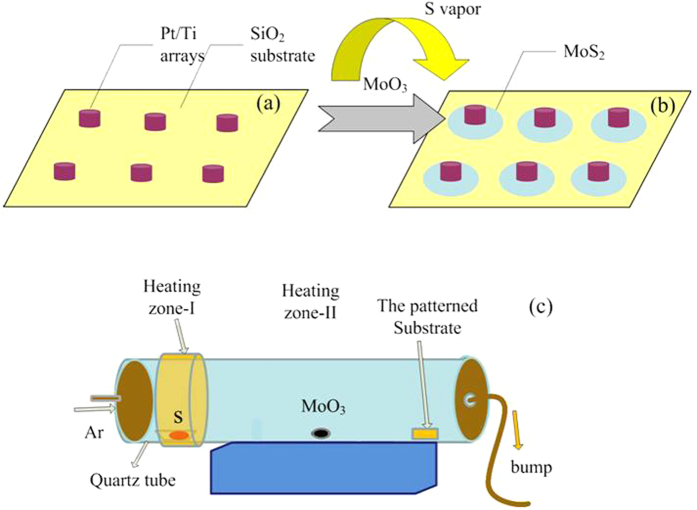
(a,b) Schematic of the growth process of the monolayer MoS2 arrays using the patterned Pt/Ti as cores deposited on SiO2/Si substrate, and (c) Experimental setup of the CVD system.